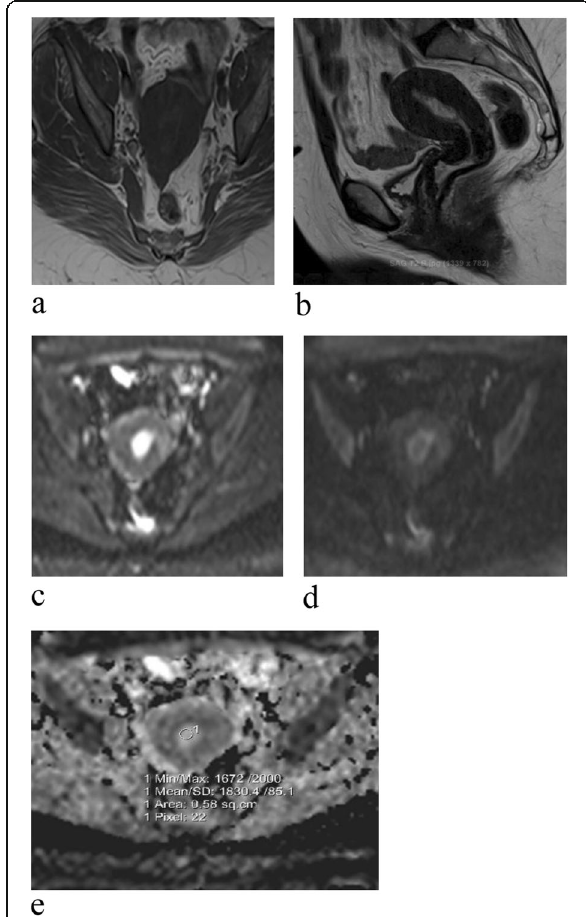
Fig. 1 Sagittal T2-WI ( b ) revealed a well-defined, small, hyperintense lesion inside the endometrium. Axial T1-WI ( a ) showed a hypointense signal intensity from the lesion. Diffusion-weighted imaging at b = 0 ( c ) and b = 1000 ( d ) showed a low signal intensity from the lesion at high b values (benign feature). ADC mapping ( e ) showed a high SI from the mass lesion with an ADC of 1.83 × 10 − 3 mm 2 /s. Radiological diagnosis: small benign featuring lesion seen inside the endometrium likely endometrial polyp. Final diagnosis (according to histopathology): endometrial polyp